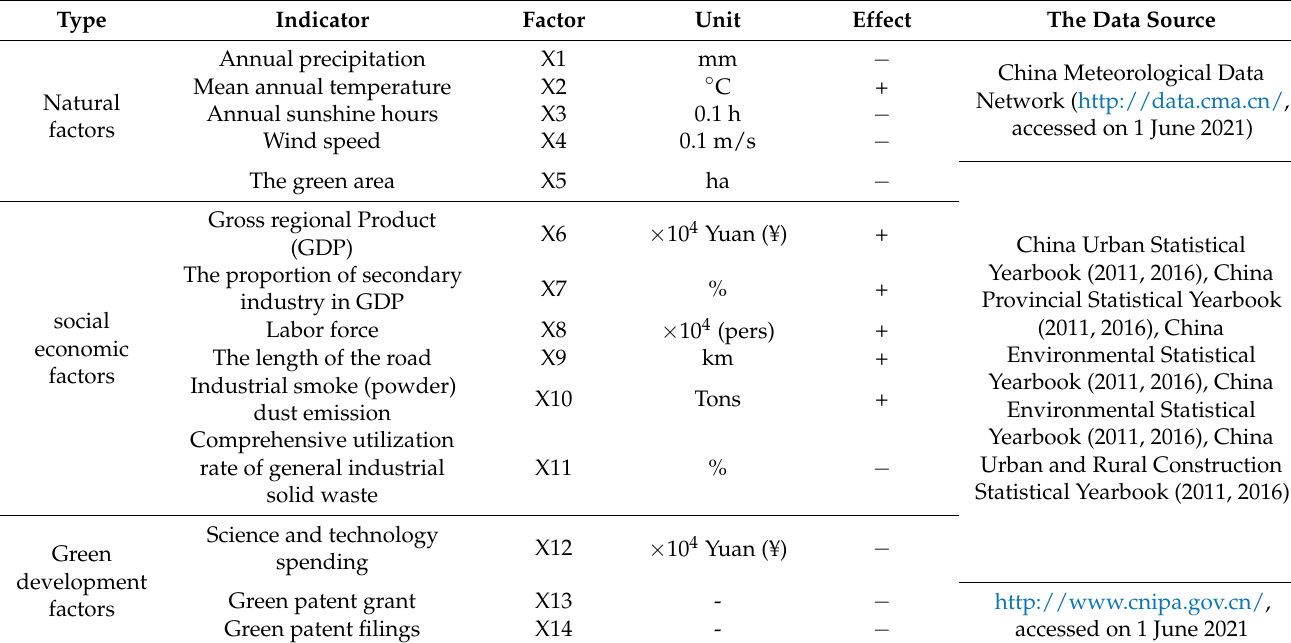
Table 1. The 14 influencing factors for three types (natural factors, social economic factors, and green development). The effect shows the positive or negative effect on PM 2.5Cement